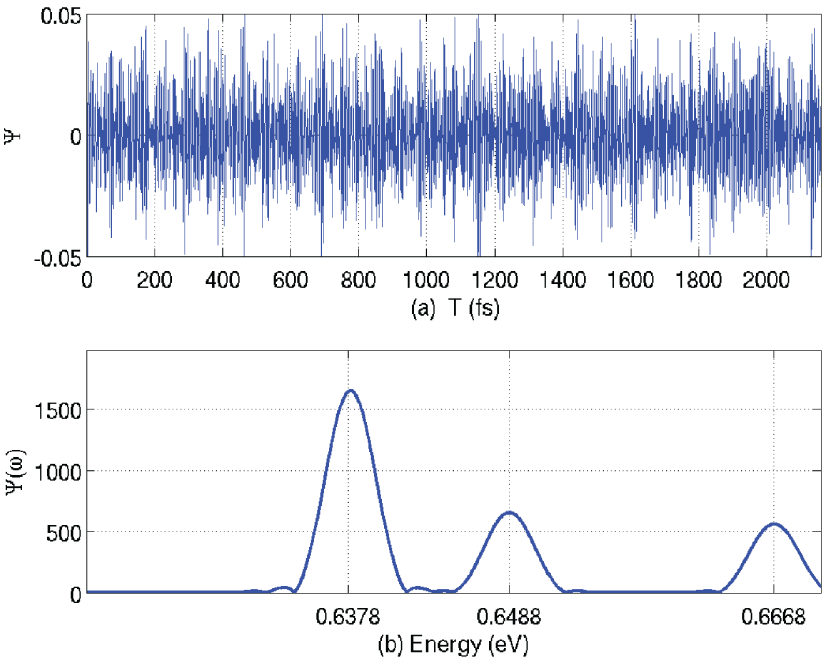
Fig 5. (a) The stored time-domain data; (b) the Fourier transform. Frequency has been converted to energy.